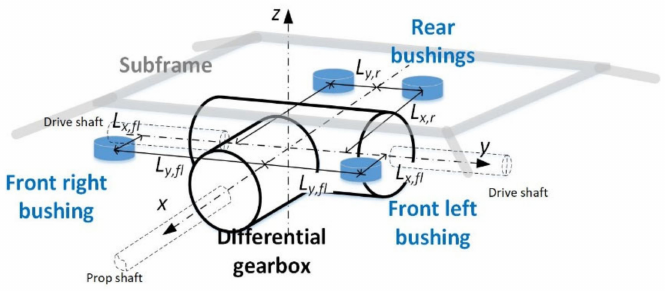
Figure 1. Schematic of local subsystem of rear differential and rear